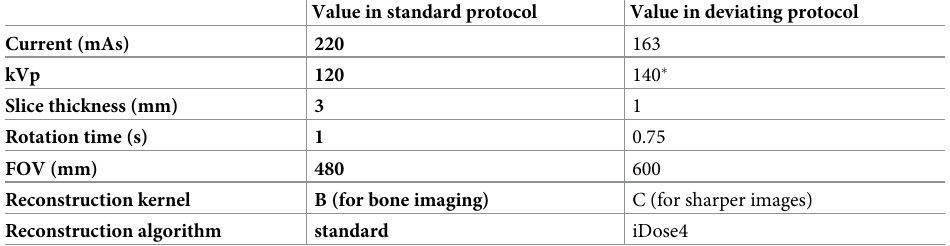
Table 1. Overview of the different scan protocols and the corresponding CT settings. Standard protocol covers the CT settings that are standard for scans made at the Radiotherapy department of the Radboudumc. All other protocols deviate one setting from the standard